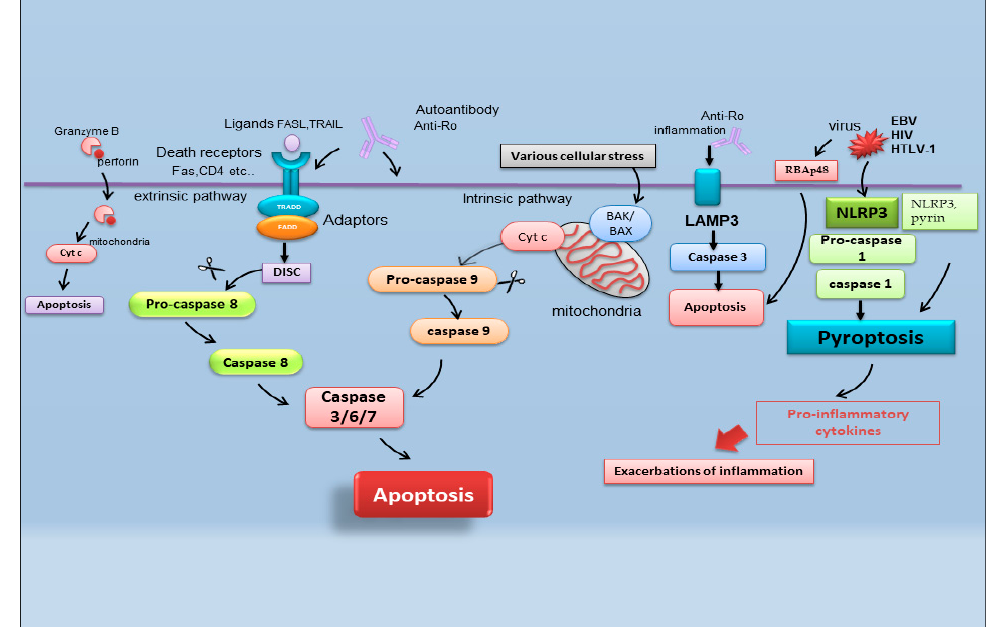
Figure 2. Schematic representation of recently identified apoptotic events in SS. B-cell lymphoma protein 2 antagonist killer 1 (BAK); B-cell lymphoma protein-2-associated X protein (BAX); cytochrome c (Cyt c); death-inducing signaling complex (DISC); Epstein–Barr virus (EBV); fatty acid synthetase ligand (FASL); Fas-associated protein with death domain (FADD); human immunodeficiency virus (HIV); human T-cell leukemia virus type 1 (HTLV-1); lysosome-associated membrane protein 3 (LAMP3); nucleotide-binding domain (NOD)-like receptor protein 3 (NLRP3); tumor necrosis factor receptor type 1-associated DEATH domain (TRADD); TNF-related apoptosis-inducing ligand (TRAIL) retinoblastoma-associated protein 48 (RBAp48).